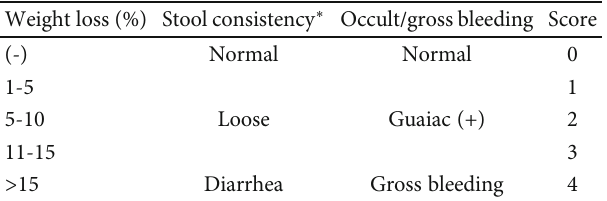
Table 1: Disease activity index.